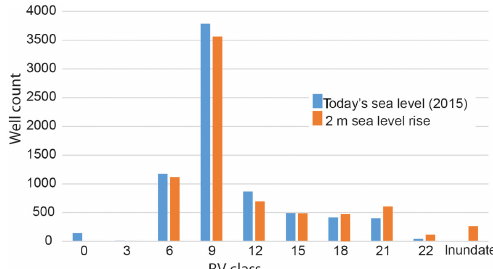
Figure 7. Risk value classes of wells on Gotland for today’s (2015) sea level and after 2m sea level rise. The number of wells in higher- risk classes will increase. Wells below 2m above the current sea level will be